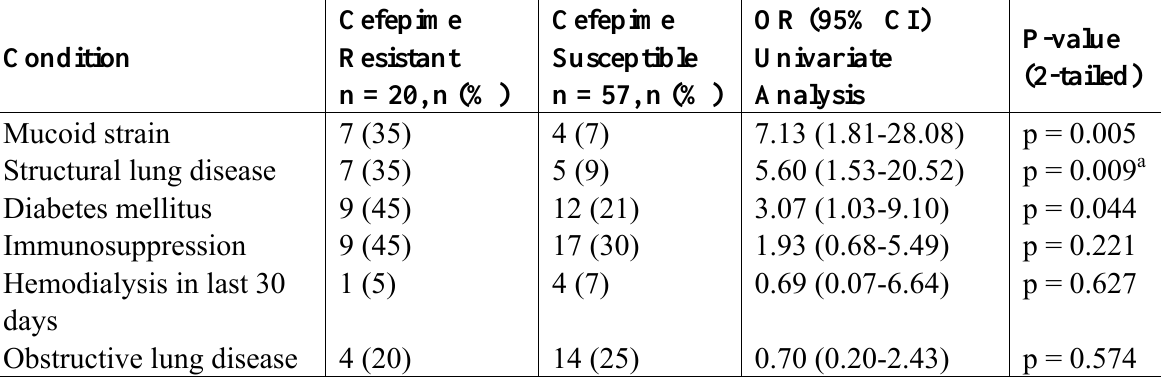
Table 2. Risk Factors for cefepime-resistant (intermediate or fully-resistant) Pseudomonas aeruginosa isolates (non-ICU adult patients, January-June